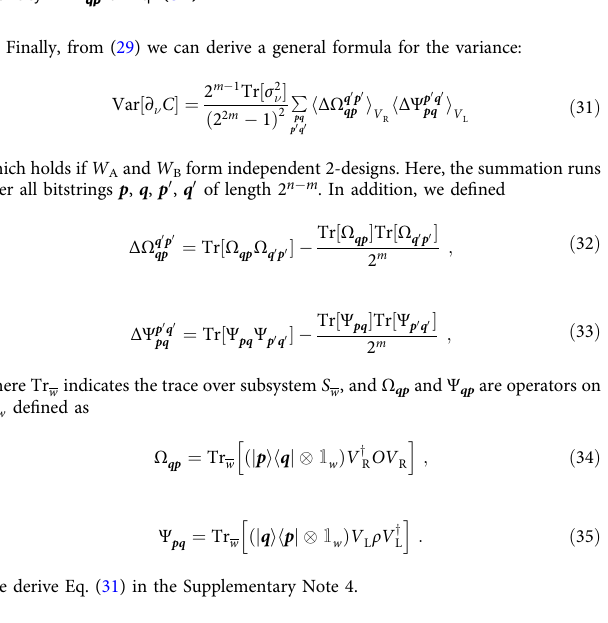
Fig. 7 The block W is in the fi rst layer of V ( θ ), and the operator O i acts on the topmost m qubits in the forward light-cone L of W . Dashed thick lines indicate the backward light-cone of O i . All but L − 1 blocks simplify to identity in Ω qp of